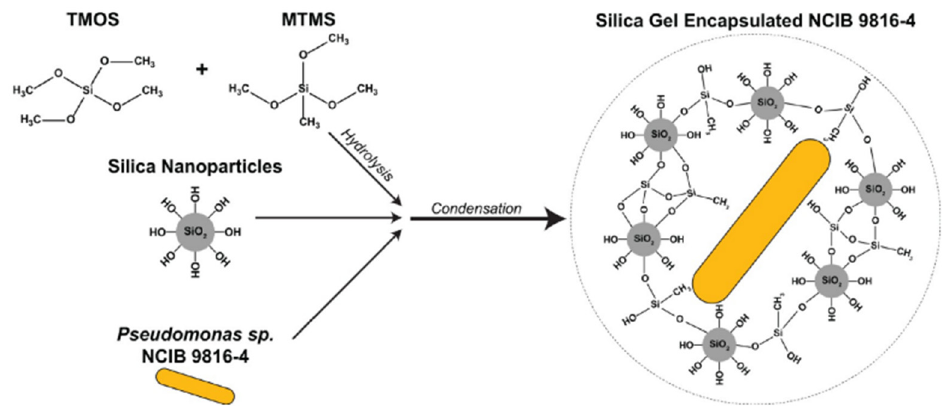
Figure 5. Synthesis process of the silica biogel through hydrolysis of TMOS and MTMS and conden- sation by mixing the hydrolyzed monomers with colloidal SNPs and Pseudomonas sp. NCIB 9816-4. Reprinted with permission from [45].